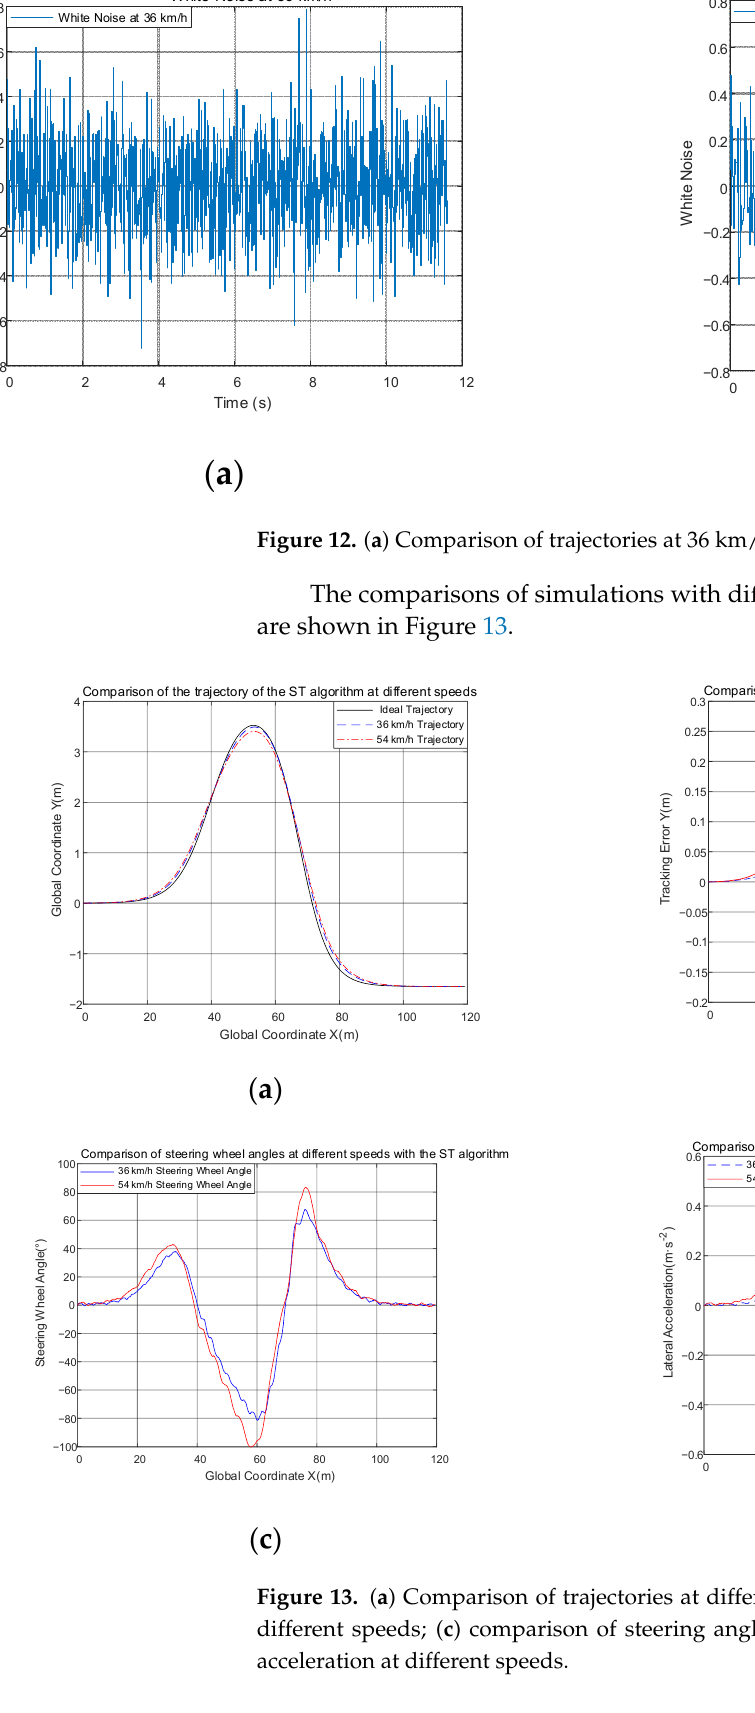
Figure 13. ( a ) Comparison of trajectories at different speeds; ( b ) comparison of tracking error at different speeds; ( c ) comparison of steering angle at different speeds; ( d ) comparison of lateral ac- celeration at different speeds.